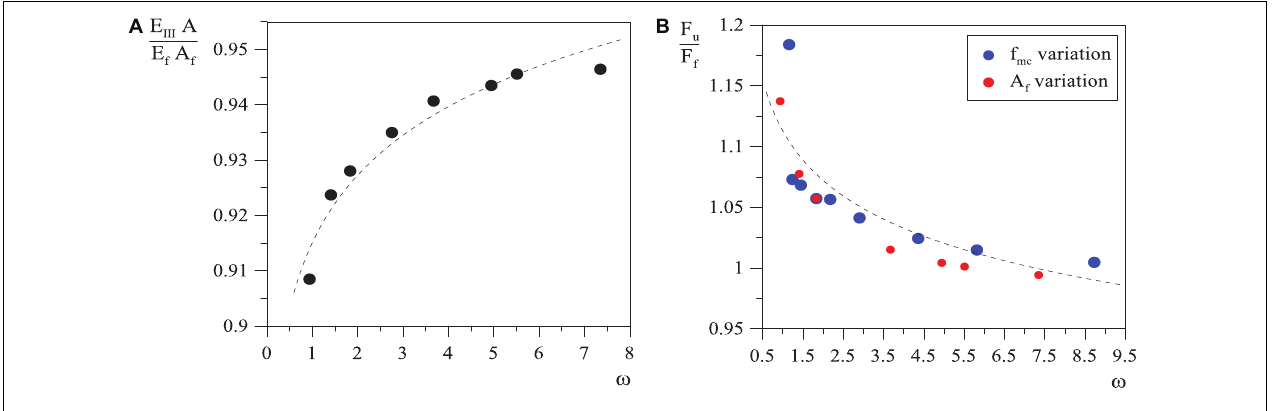
FIGURE 12 | Parametric study: (A) axial stiffness in the III stage; (B) ultimate tensile